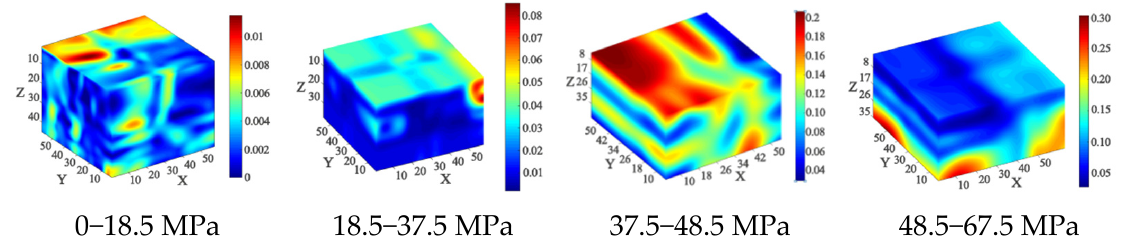
Figure 16. Evolution process of equivariant strain nephogram.